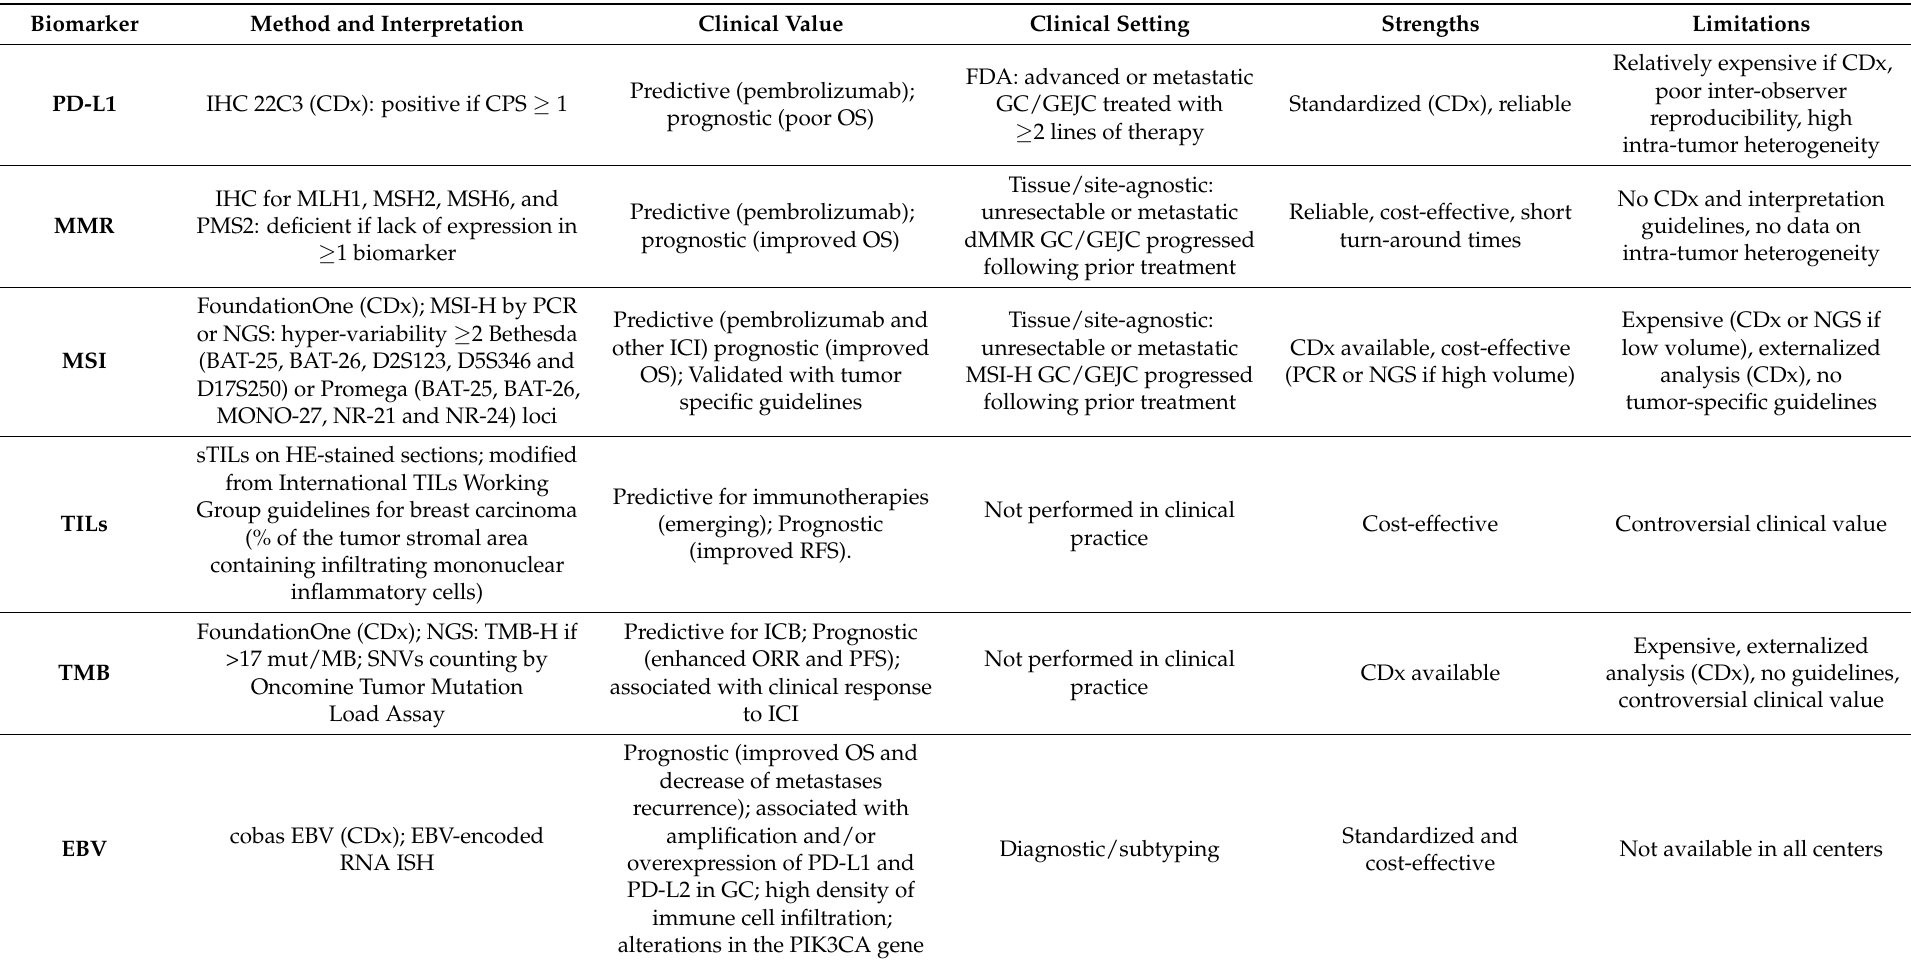
Table 1. Biomarkers for immunotherapy: detection methods, strengths and